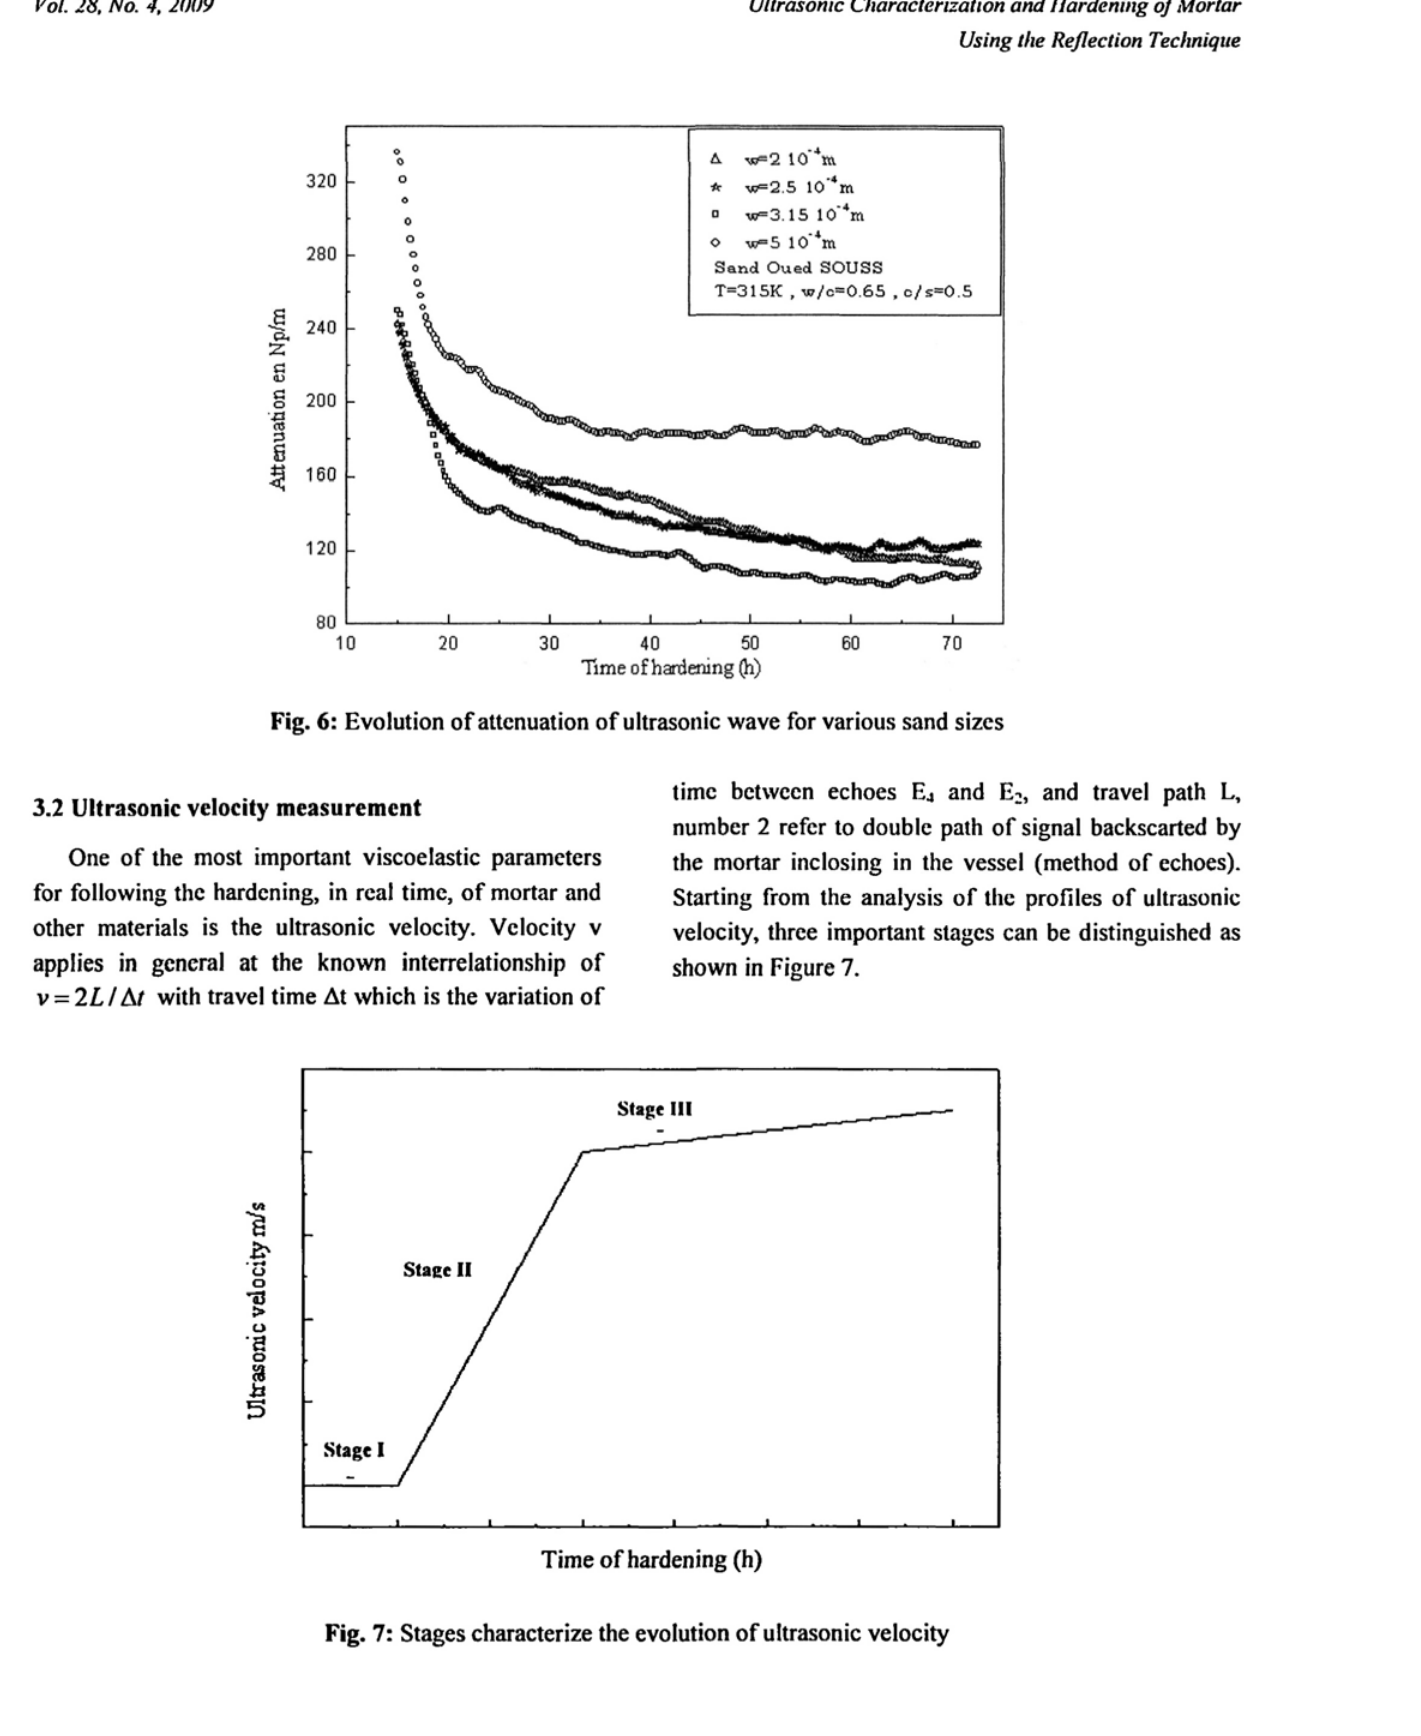
Fig. 7: Stages characterize the evolution of ultrasonic